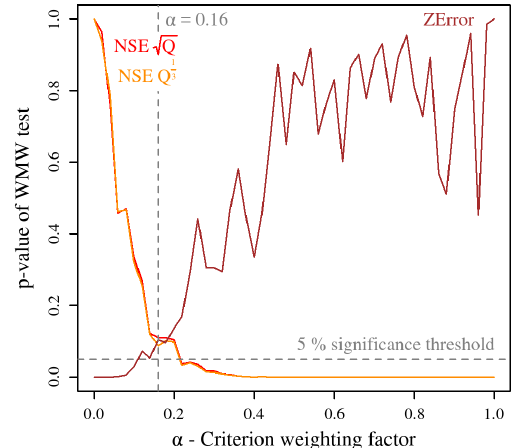
Figure 8. p -values of the Wilcoxon–Mann–Whitney (WMW) tests comparing the criteria value distributions obtained for the 51 values of α with reference